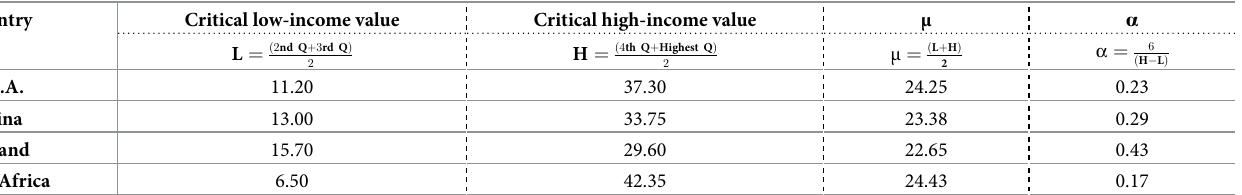
Table 2. Parameter values for the individual social welfare functions. Country Critical low-income value Critical high-income